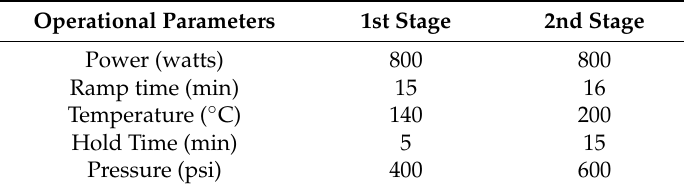
Table 3. Operational conditions of microwave digestion